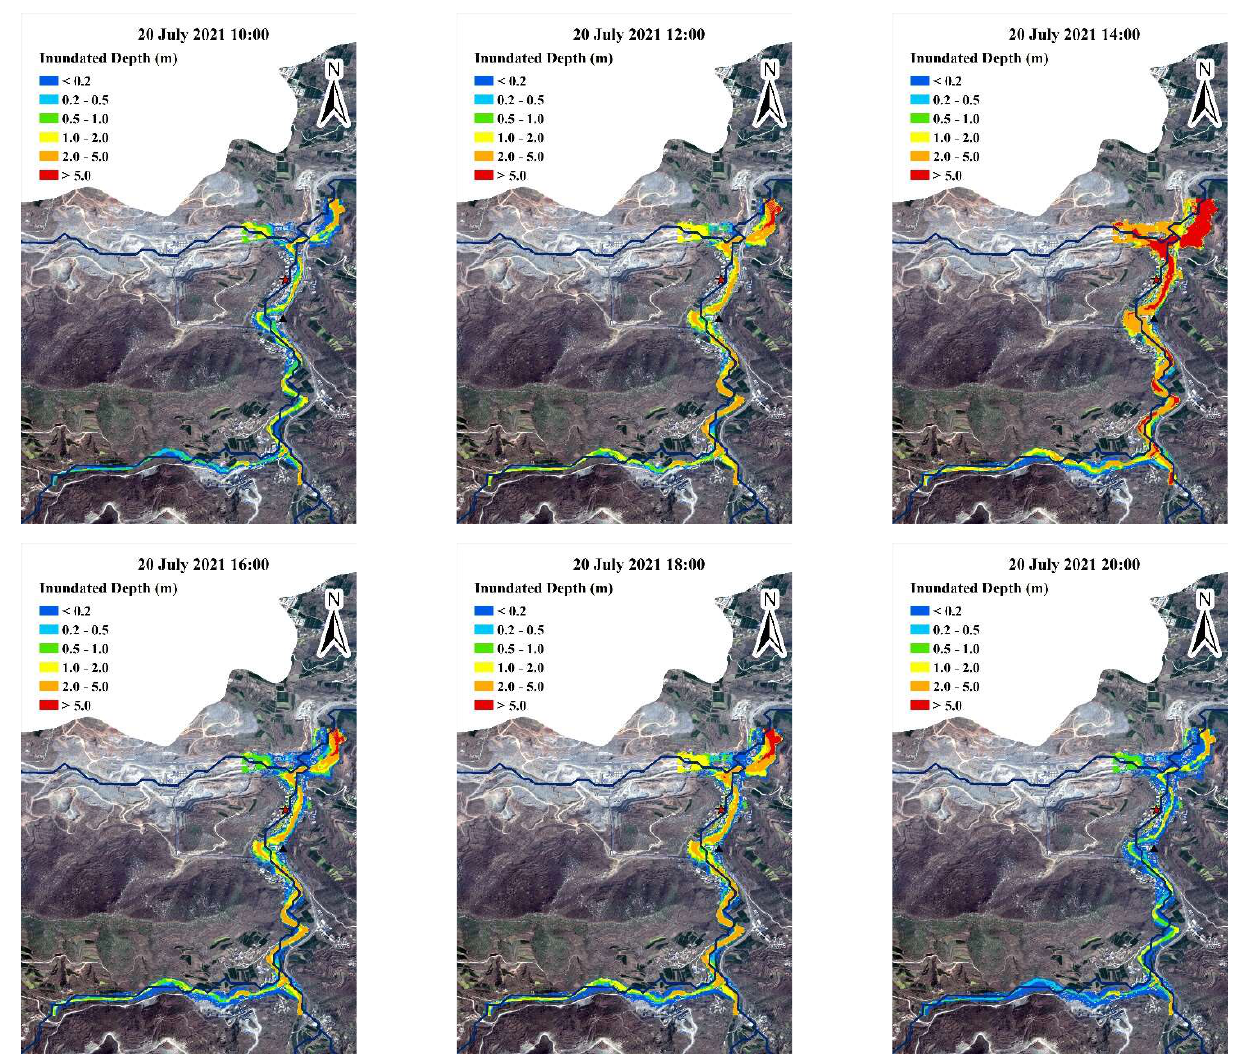
Figure 9. Hydrodynamic model simulation results.